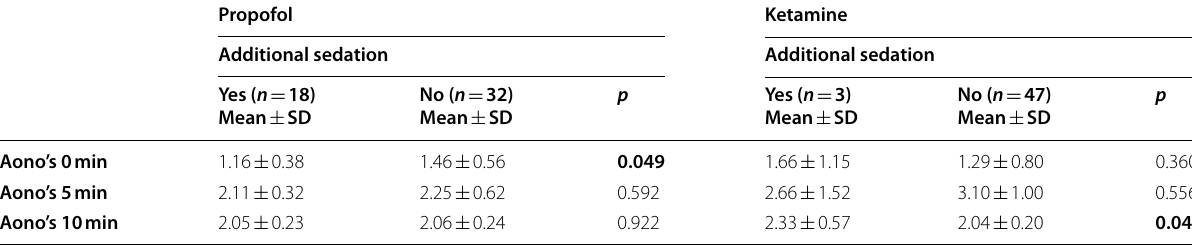
Table 6 Comparison of additional sedation in propofol and ketamine groups according to Aono’s four-point scale (AFPS)